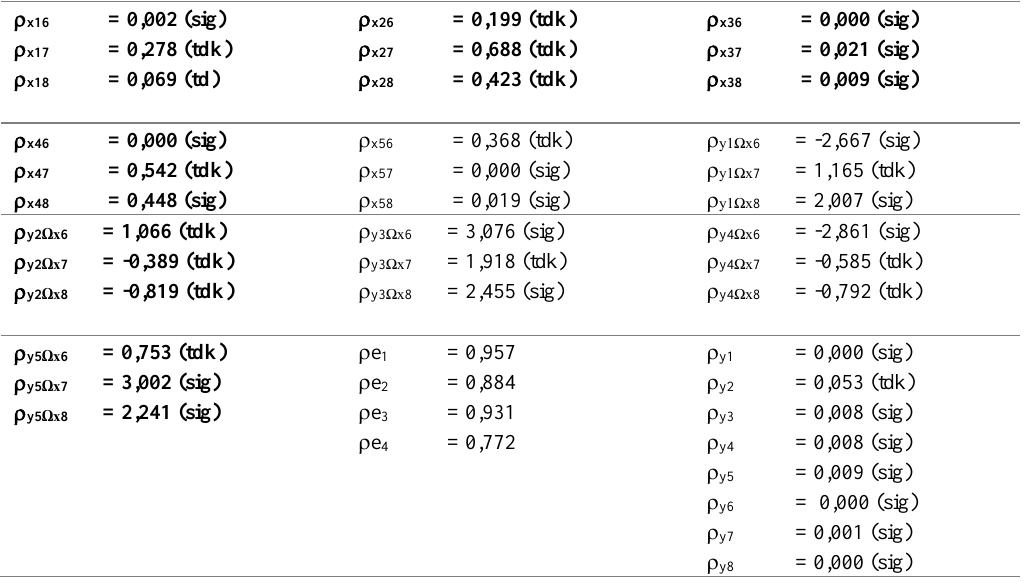
Table 1 : Findings Summary